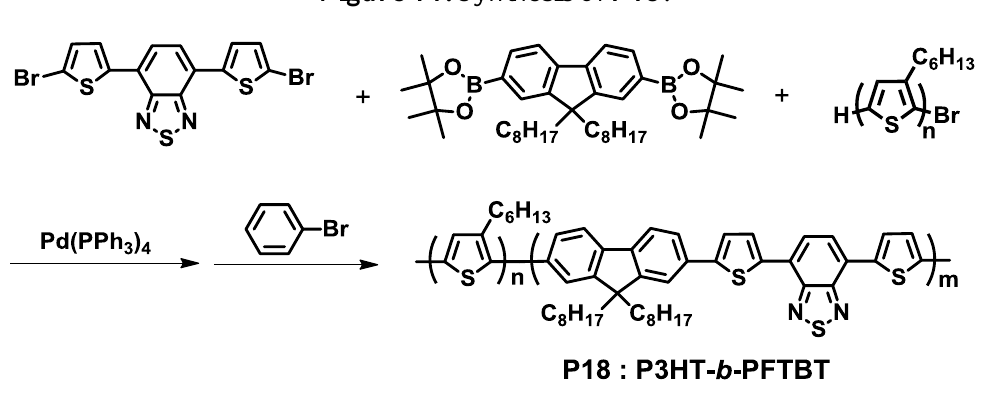
Figure 14. Synthesis of P18